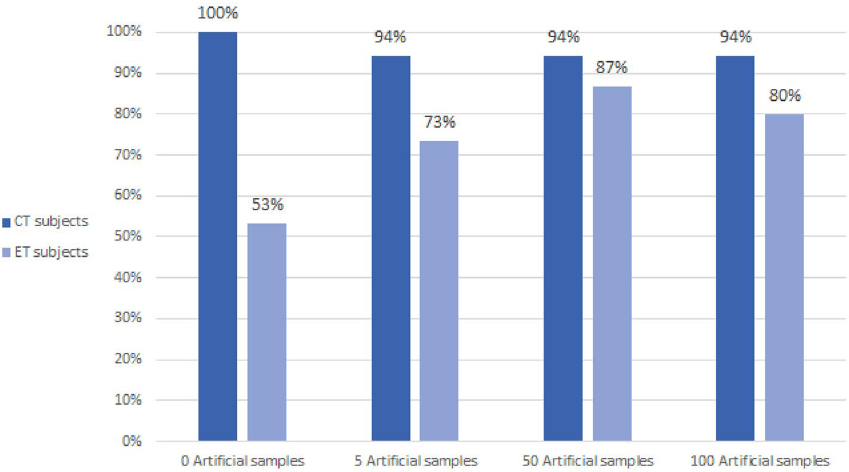
Figure 6. True negative rate (CT subjects) and true positive rate (ET subjects) depending on the number of artificial frames for the same subjects in the training step.